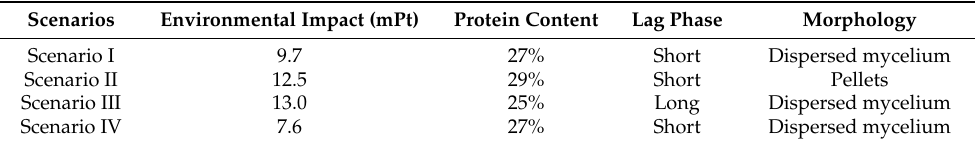
Table 3. Summary of technical and environmental indicators for the scenarios assessed. The protein content refers to SSF after 6